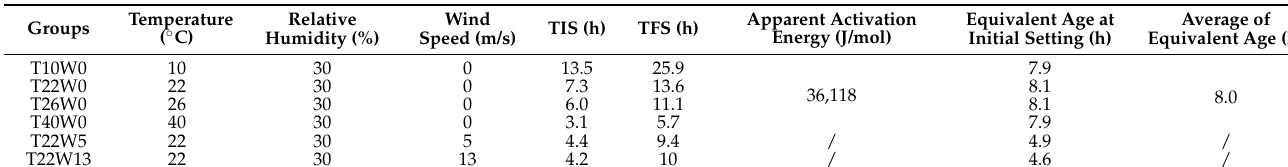
Measured value of initial setting time Measured value of final setting time Trend line of initial setting time Trend line of final setting time